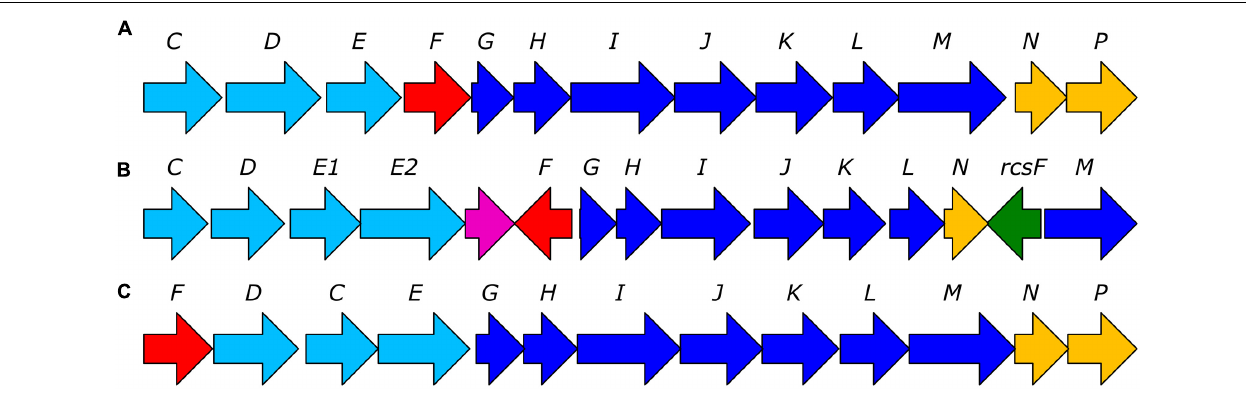
FIGURE 2 | Representative bacterial C-P lyase operons identified in HMWDOM enriched bacterial isolates. (A) The C-P lyase operon of Pseudomonas stutzeri HI00D1 (Repeta et al., 2016). (B) The C-P lyase operon of Sulfitobacter sp. HI0054. (C) A hypothetical C-P lyase operon identified in Oleiphilus sp. HI0066. The arrow color indicates genes involved in phosphonate transport (light blue), transcriptional regulation (red), catalytic functions (blue), auxiliary functions (yellow), and undetermined functions (green and violet).